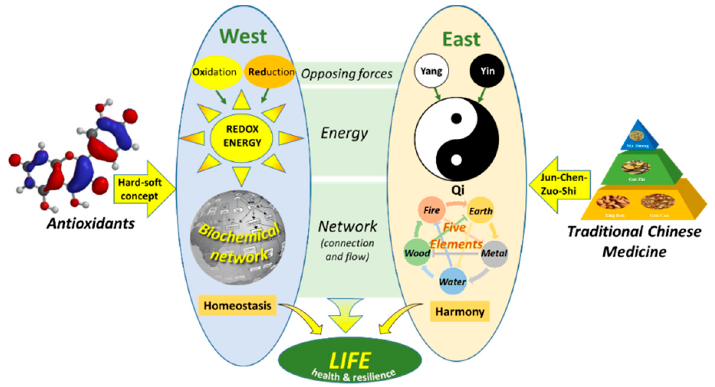
Figure 10. The connection of Western medicine and Eastern medicine from an energy perspective. In both worlds, opposing forces generate the energy that flows through networks, which fuels life. Antioxidants interact with other molecules based on the hard-soft-acid-base concept, which can be used to regain homeostasis. In TCM, different herbs are combined based on the rule of ‘Jun-Chen- Zuo-Shi’ to restore the energy of Qi in the network to regain harmony, taken from Zhang et al. [4].